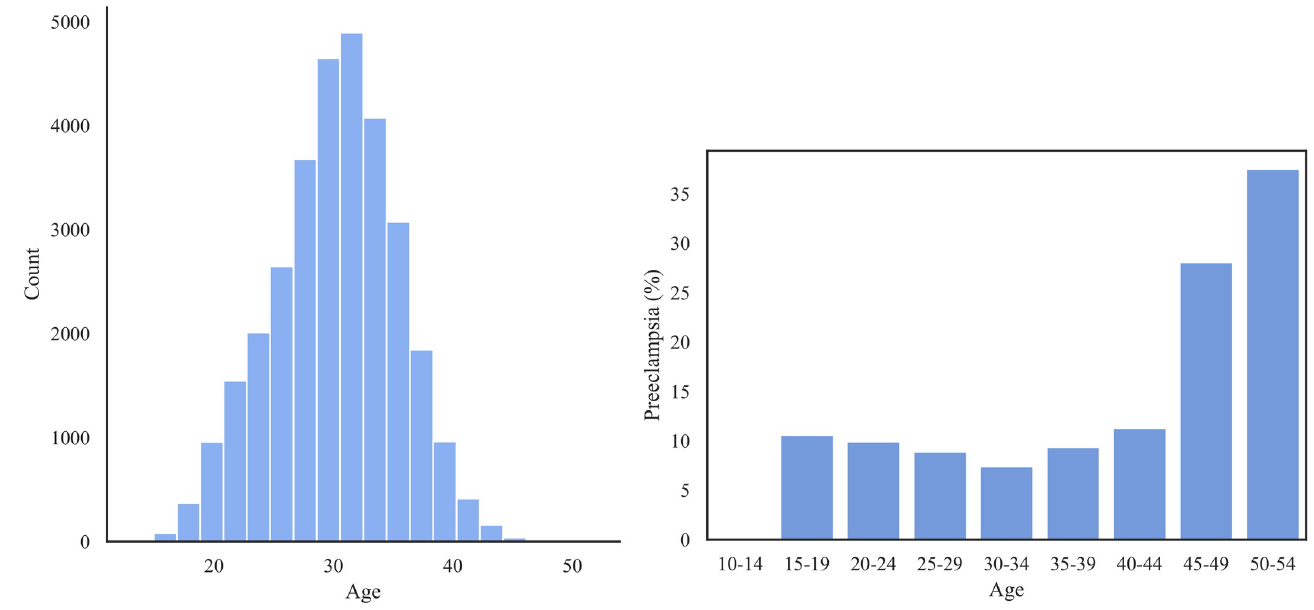
Fig 8. Left: The distribution of age group in the MOMI dataset; Right: The prevalence of PE (%) for each age group.